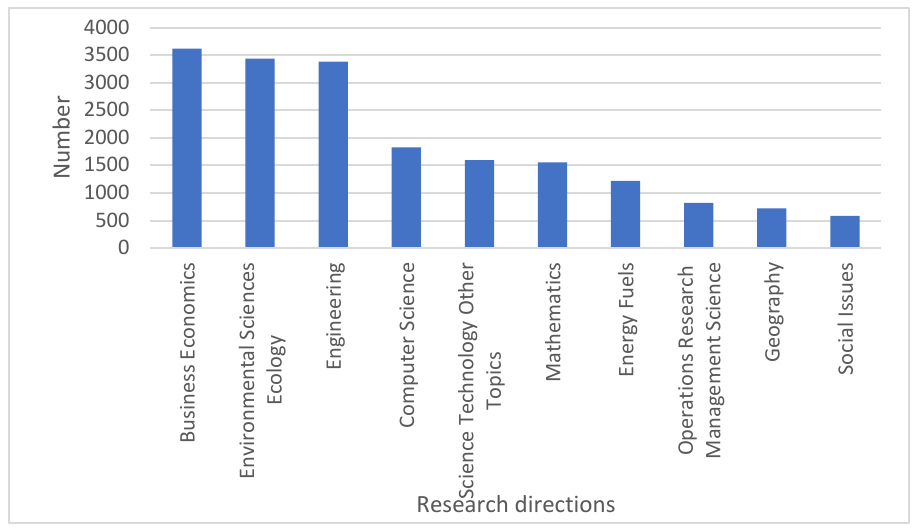
Figure 2. Distribution of literature research fields.